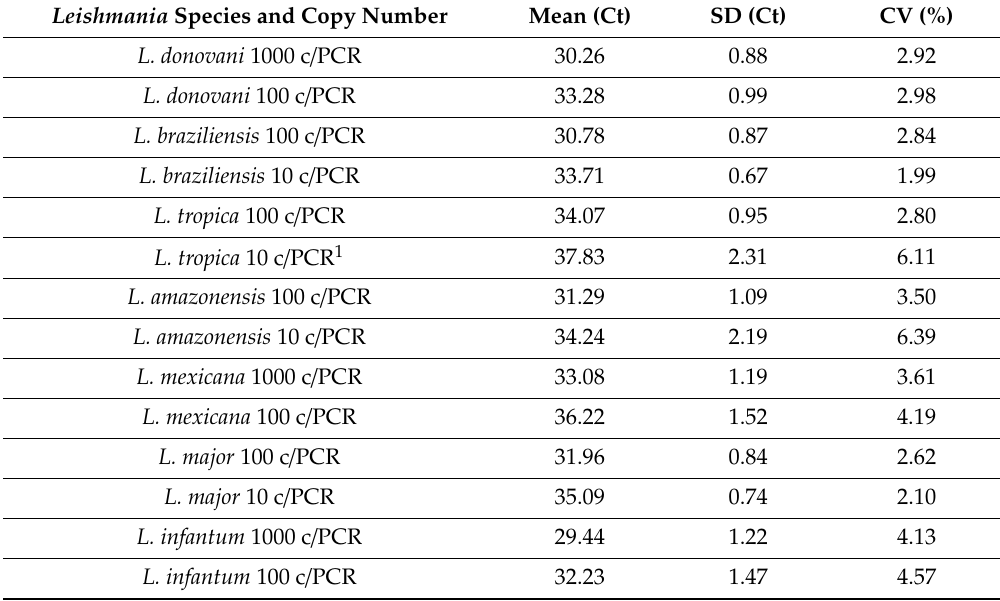
Table 3. Summary of the Observed Precision Estimates for the novel assay. Leishmania Species and Copy